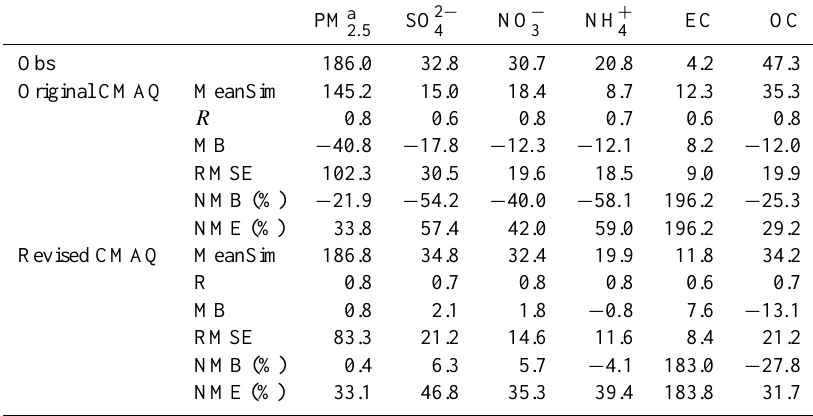
Table 7. Performance statistics of the original and revised CMAQ model at the THU site.